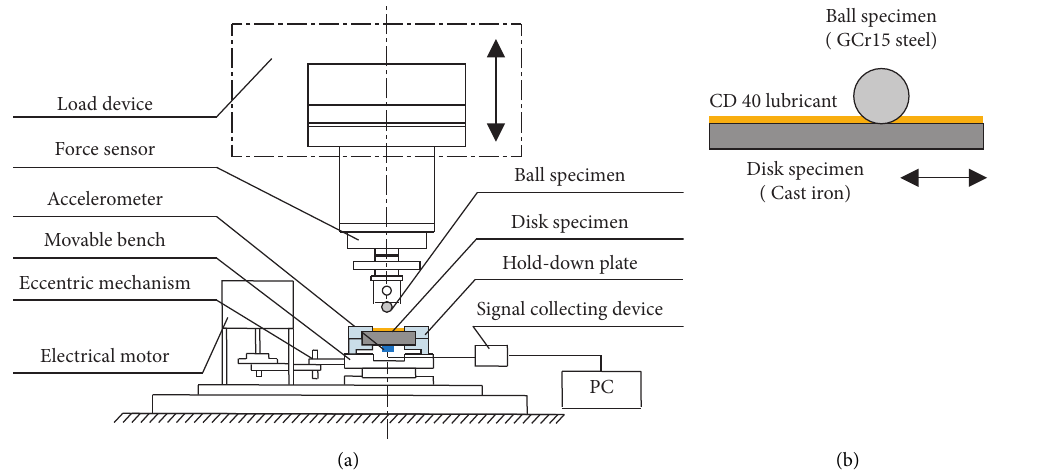
Figure 1: Schematic diagram of the testing machine: (a) testing machine; (b) friction